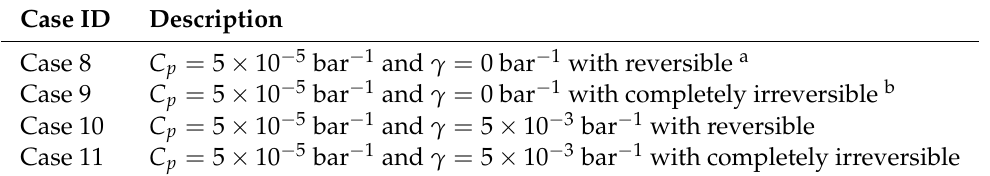
Table 3. Descriptions of the simulation cases for studying the influence of the reservoir rock com- paction and its reversibility (cases 8 to